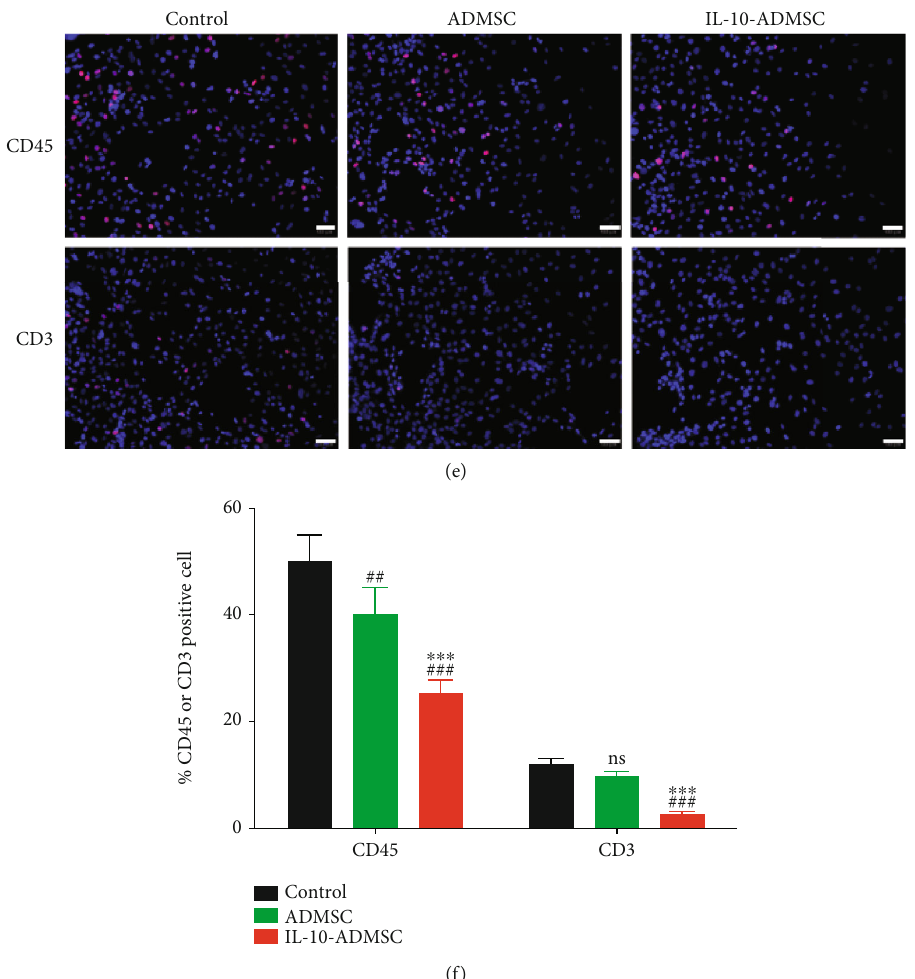
Figure 8: IL-10-modi fi ed ADMSC regulated wound in fl ammation. (a – d) After 3 days of treatment in di ff erent ways, we detected the expression of MCP-1, MIP-1 β , IL-1 β , and IL-6mRNA expression in wound by RT-qPCR. (e, f) After 3 days of treatment in di ff erent ways, we detected CD45 and CD3 positive cell in the wound using immuno fl uorescence (e, f). n = 6 ; scale bar: 10 μ m. Data was expressed as ( SD ± mean ); P value was calculated by one-way ANOVA; ∗∗∗ was P < 0 : 001 vs. ADMSC group; ns was P > 0 : 05 , ## was P < 0 : 001 , and ### was P < 0 : 001 vs. control